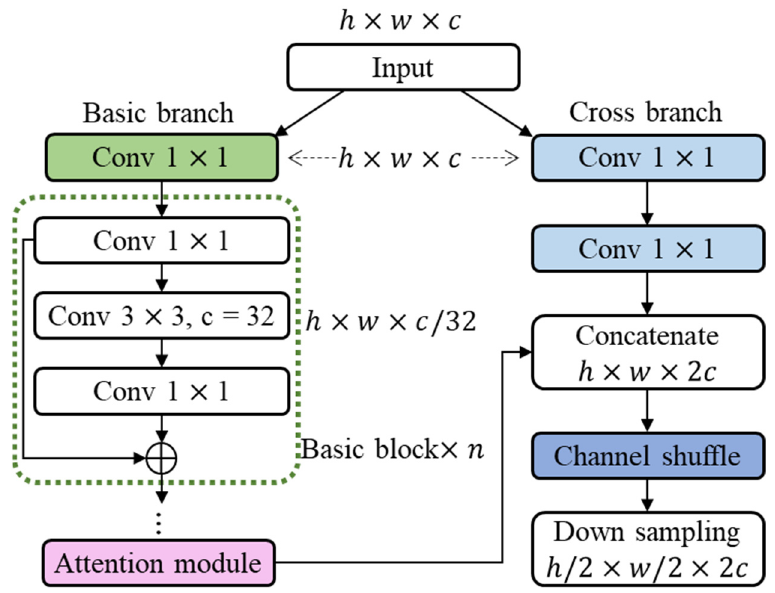
Figure 4. Schematic of improved CSP ‐ stage module.